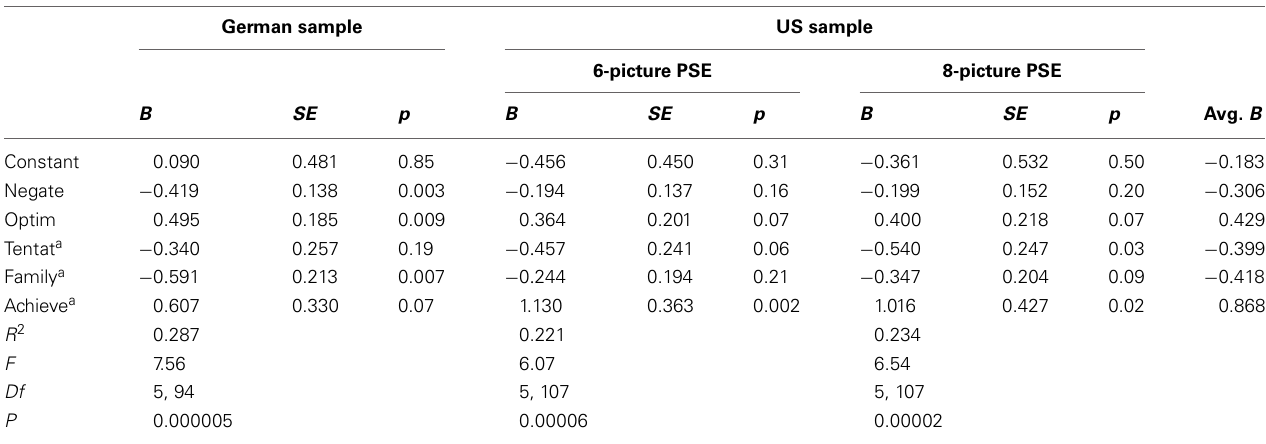
Table 4 | Simultaneous regression of n Achievement scores (residualized for word count) on LIWC 2001 categories that are significant zero-order predictors in both samples and are non-redundant (Study